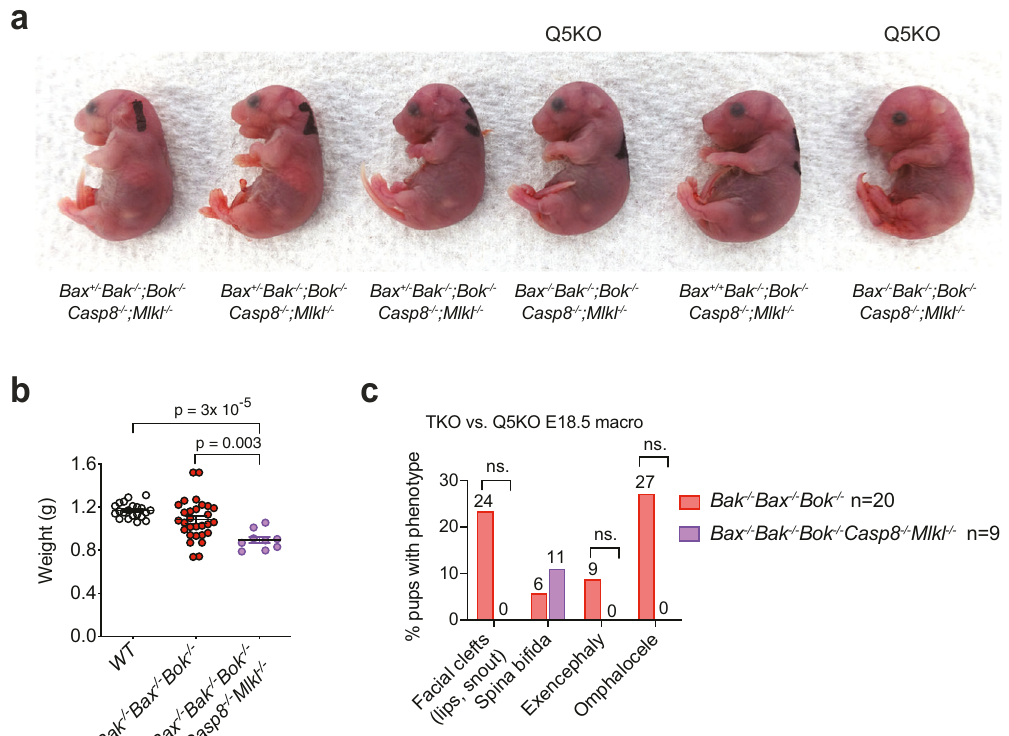
Fig. 2 E18.5 Bax − / − ;Bak − / − ;Bok − / − ;Casp8 − / − ;Mlkl − / − quintuple knockout (Q5KO) foetuses display a reduction in body weight and externally visible anomalies. a Representative image of a litter of E18.5 foetuses of a mating between a Bax + / − ;Bak − / − ;Bok − / − ;Casp8 − / − ;Mlkl − / − female and a Bax + / − ;Bak − / − ;Bok − / − ;Casp8 − / − ;Mlkl − / − male. Offspring genotypes are indicated. b Body weights of E18.5 foetuses of the indicated genotypes. Data are presented as mean ± SEM; p , one-way ANOVA followed by multiple comparison and Tukey correction for multiple testing. Each dot represents an individual foetus. c Percentages of E18.5 Bax − / − ;Bak − / − ;Bok − / − ;Casp8 − / − ;Mlkl − / − quintuple knockout and Bax − / − ;Bak − / − ;Bok − / − triple knockout foetuses exhibiting externally visible developmental defects (numbers above bars represent the percentages of animals) compared by Fisher ’ s exact